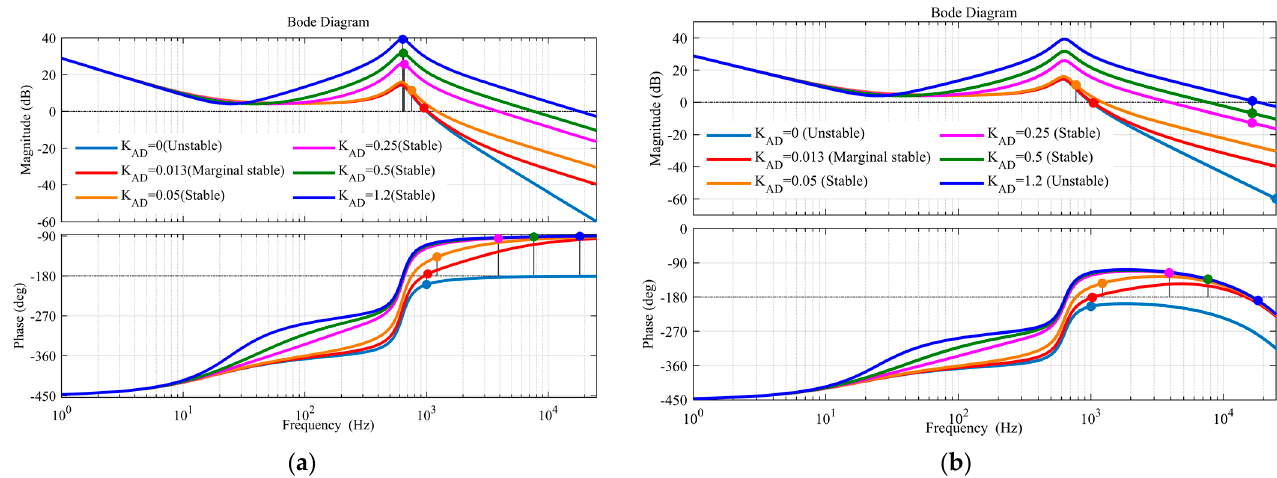
(cid:3023)(cid:3553) (cid:3290) ((cid:3046)) of buck converter: ( a ) without delay; ( b ) with delay [87]. Figure 18. Bode diagram of ˆ V o ( s ) of buck converter: ( a ) without delay; ( b ) with delay (cid:3031)(cid:3552)((cid:3046)) ˆ d ( s )